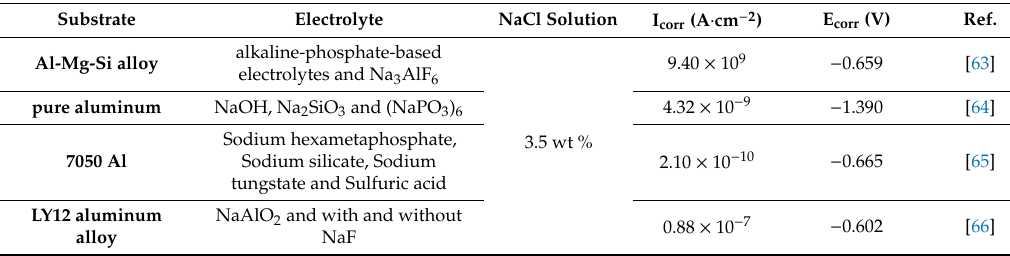
Table 5. Comparison of corrosion resistance for PEO coatings on pure aluminum and alloys substrate in literature